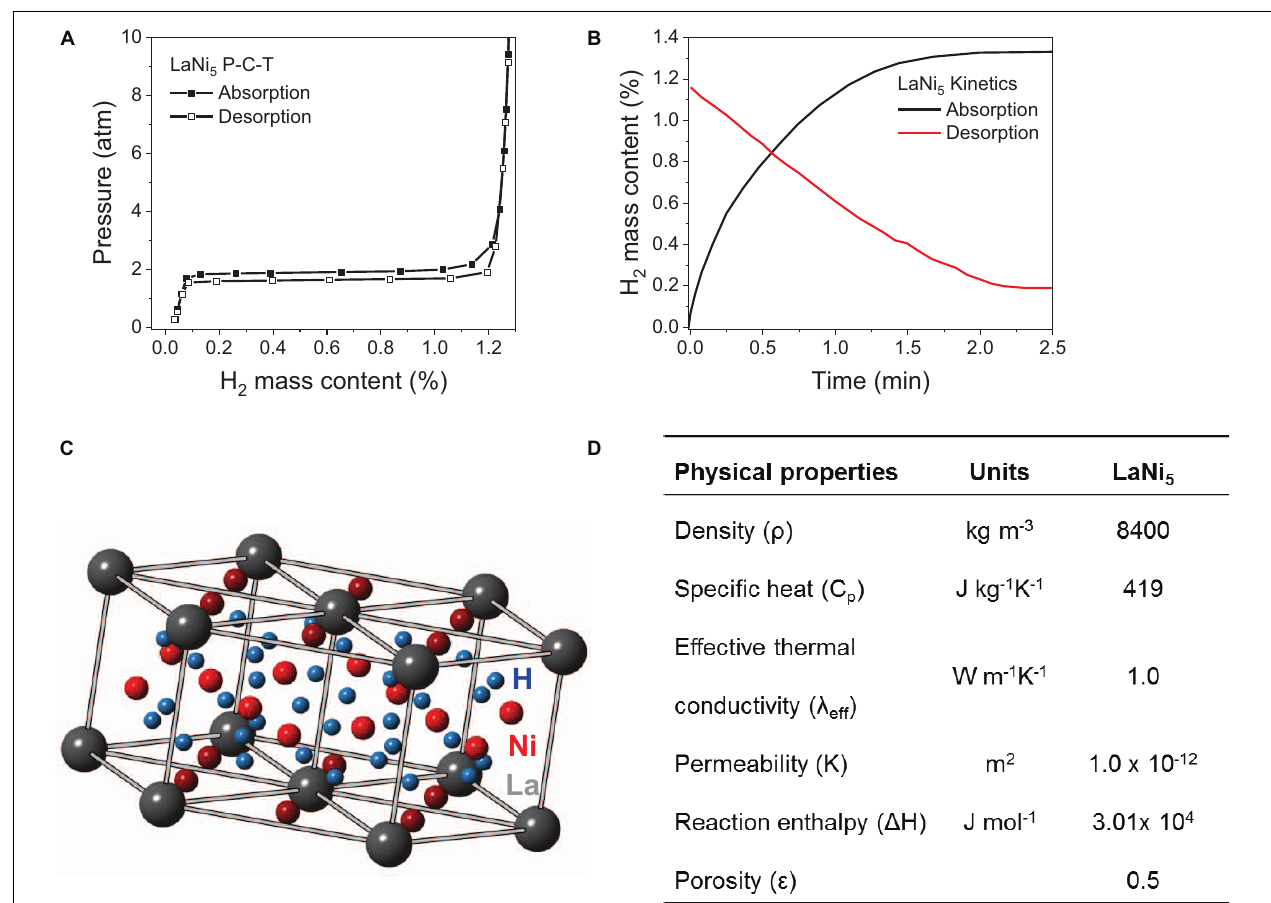
FIGURE 7 | LaNi 5 properties: (A) Absorption-desorption PCT curve at 25 ◦ C (Sandrock, 1997); (B) Kinetics showing typical 1st cycle of absorption at 25 ◦ C and 0.34 MPa (Sandrock, 1997) and desorption at 30 ◦ C and 0.05 MPa (Dhaou et al., 2007); (C) Structural properties showing CaCu5-type hexagonal structure (Liu et al., 2011); (D) Physical properties of LaNi 5 (Yang et al., 2012).